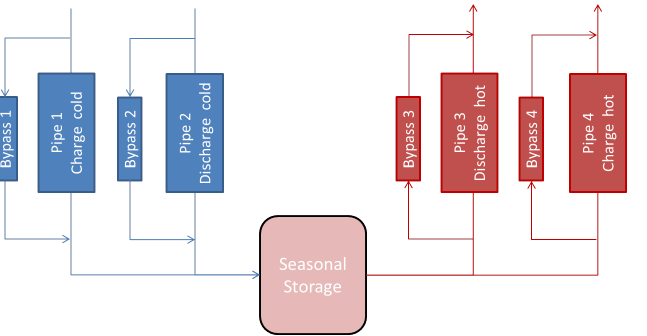
Figure 3. Four pipes network to represent a bidirectional mass flow system in the Carnot Toolbox.